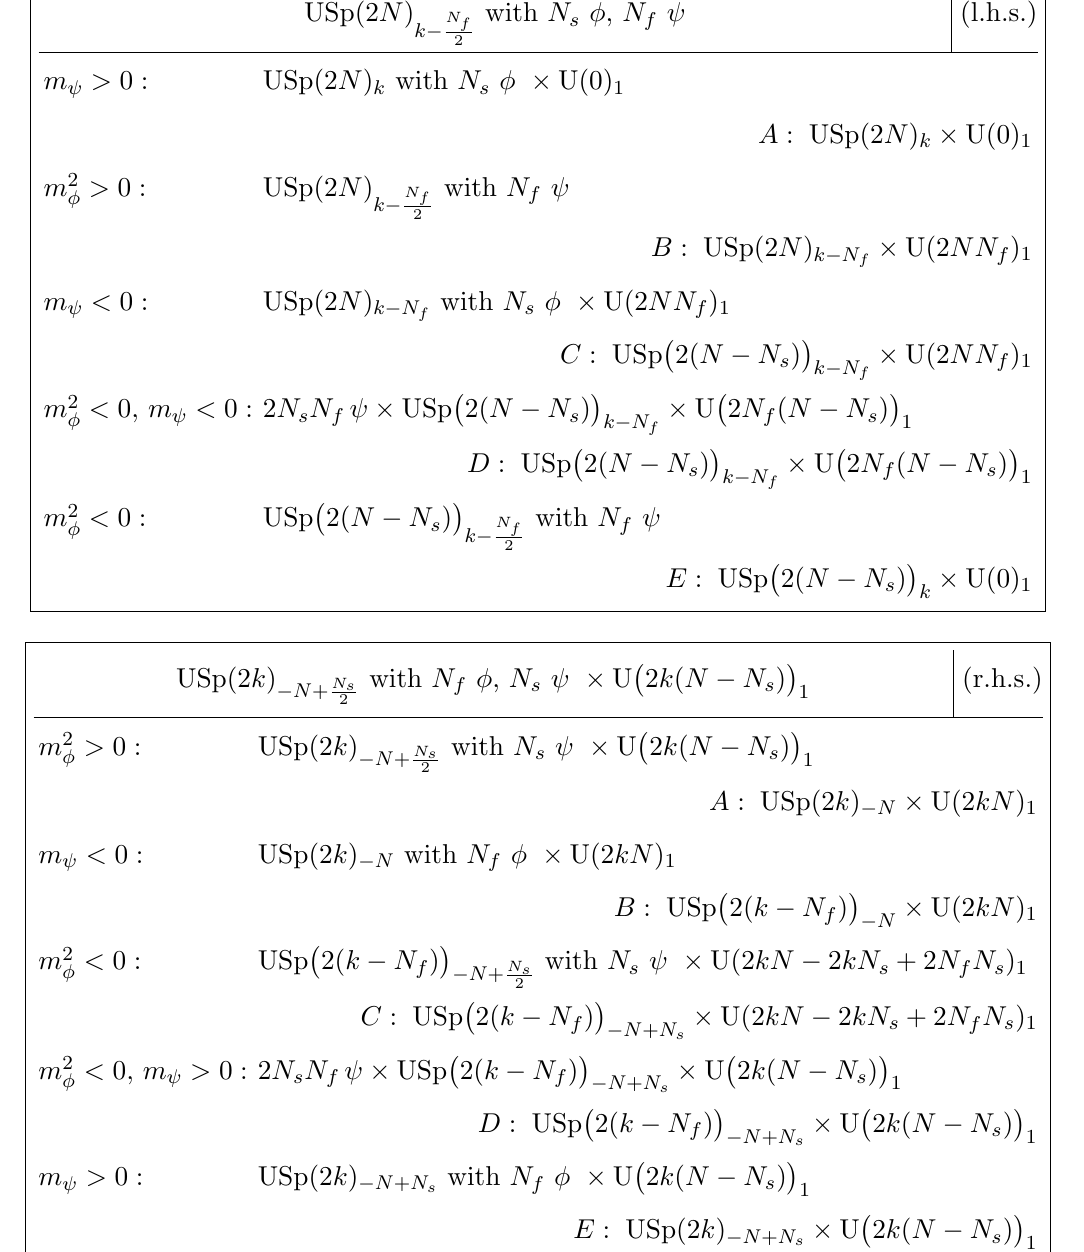
Table 4 . Phase diagram for USp dualities. These tables are valid for N s